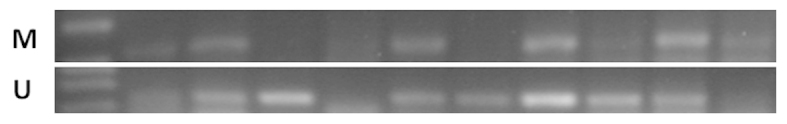
Methylation pattern of PTPL1 in diffuse large B cell lymphoma patients.